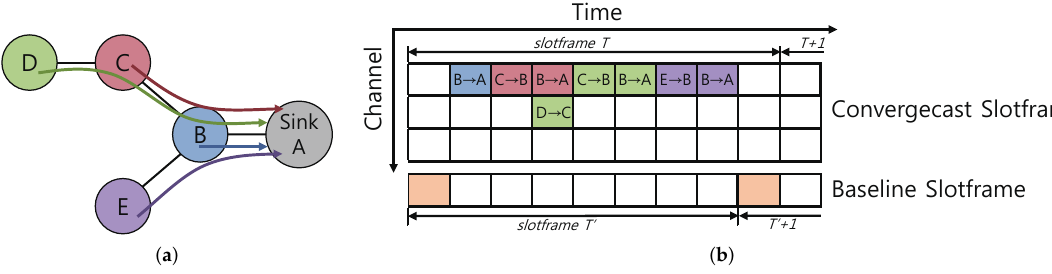
Figure 1. An example of the Escalator schedule: ( a ) network topology of the example; ( b ) Escalator’s generated schedule for the